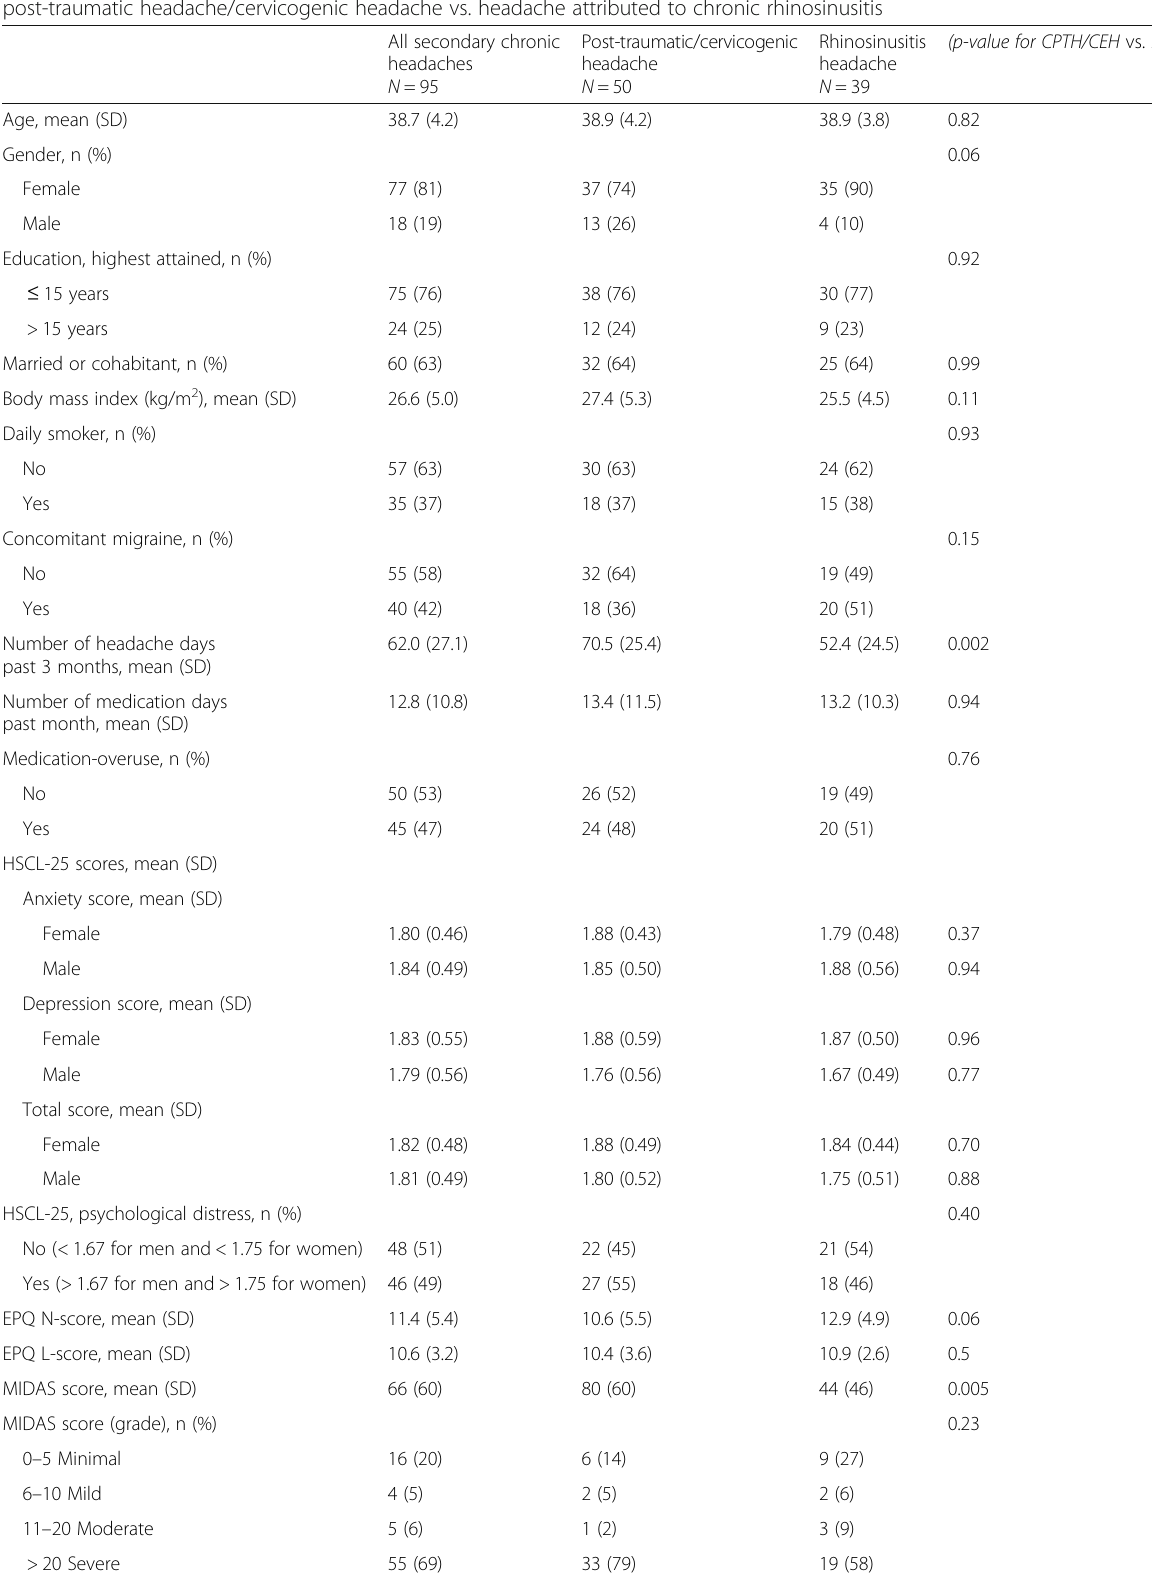
Table 1 Descriptive statistics for all respondents with secondary chronic headache. P -value given for the comparison of chronic post-traumatic headache/cervicogenic headache vs. headache attributed to chronic